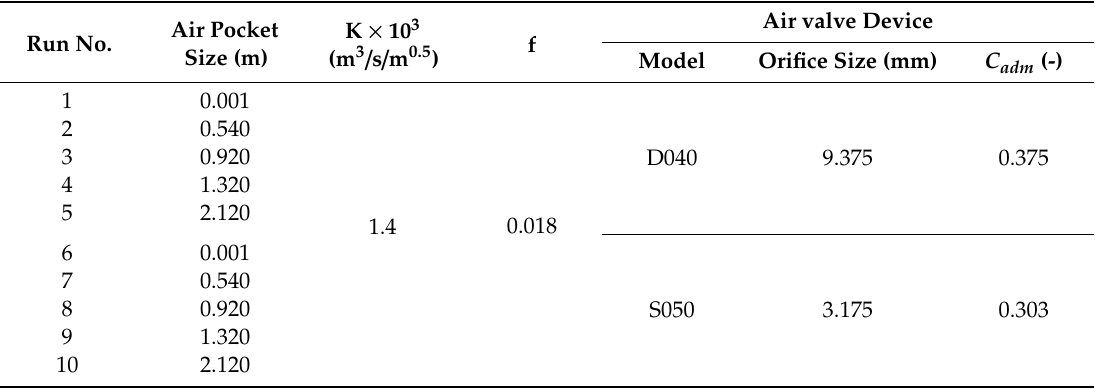
Table 1. Characteristics of